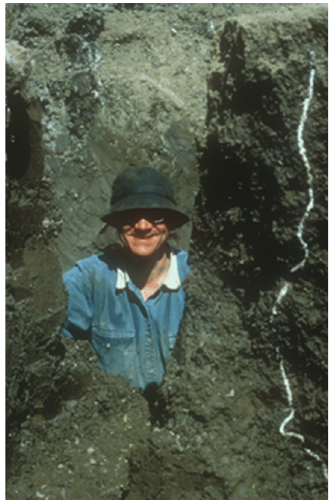
Figure 3: A burrow of Lumbricus terrestris filled with white- coloured resin and exposed in the soil profile to its terminal depth at